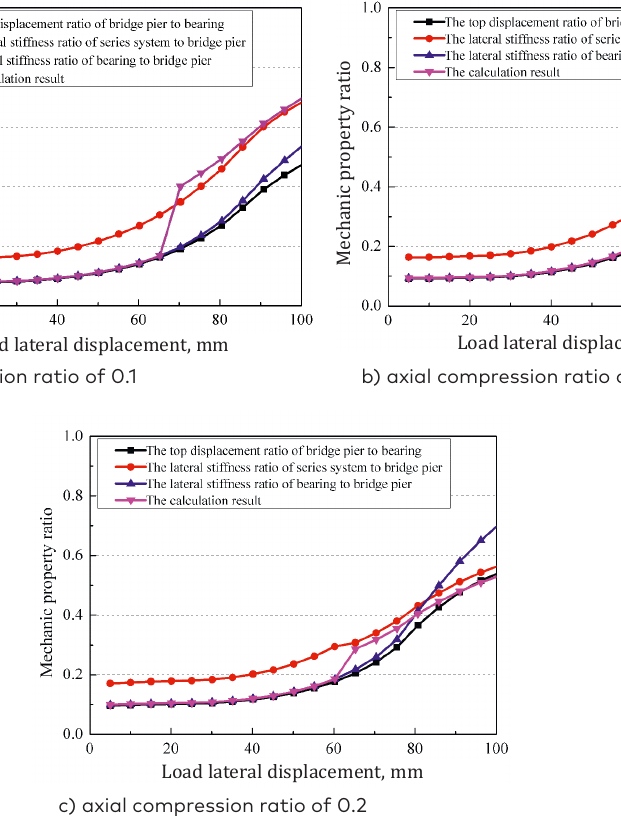
Figure 13. Mechanical properties of the series system with symmetry friction contact of friction coefficient of 0.2 at both ends of the bearing